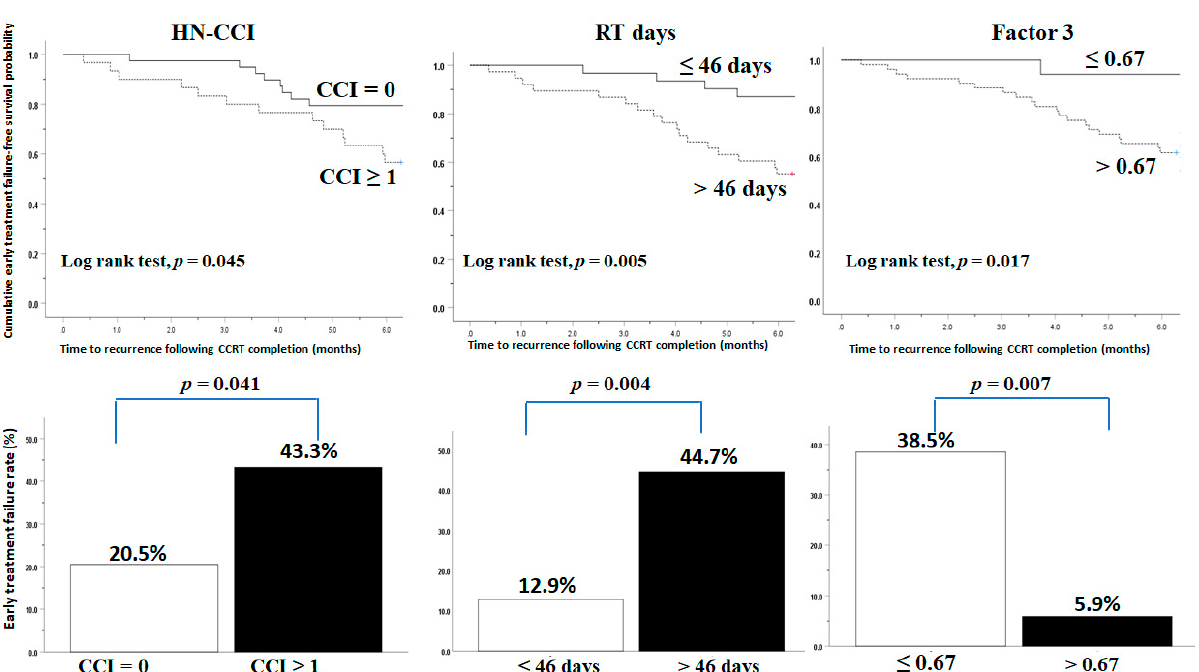
Figure 3. Early treatment failure-free survival probability or early treatment failure rates stratified by comorbidity, RT days (radiation duration), and Factor 3 (body muscle mass before CCRT). HN-CCI, head and neck Charlson Comorbidity Index; RT, radiotherapy.